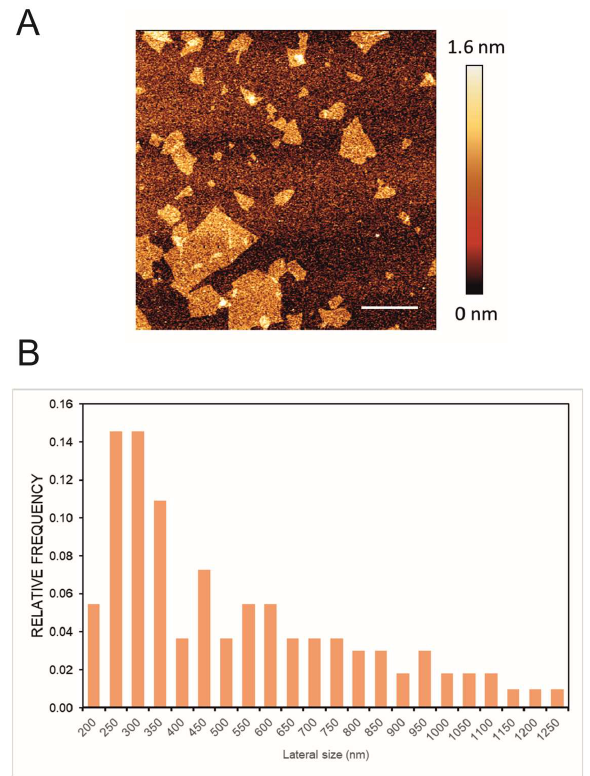
Figure 1. ( A ) Representative AFM image of GO; the scale bar is 1 µm. ( B ) Lateral size distribution of the flakes obtained through the analysis of three different images by ImageJ Fiji Software (Version 1.53 c).